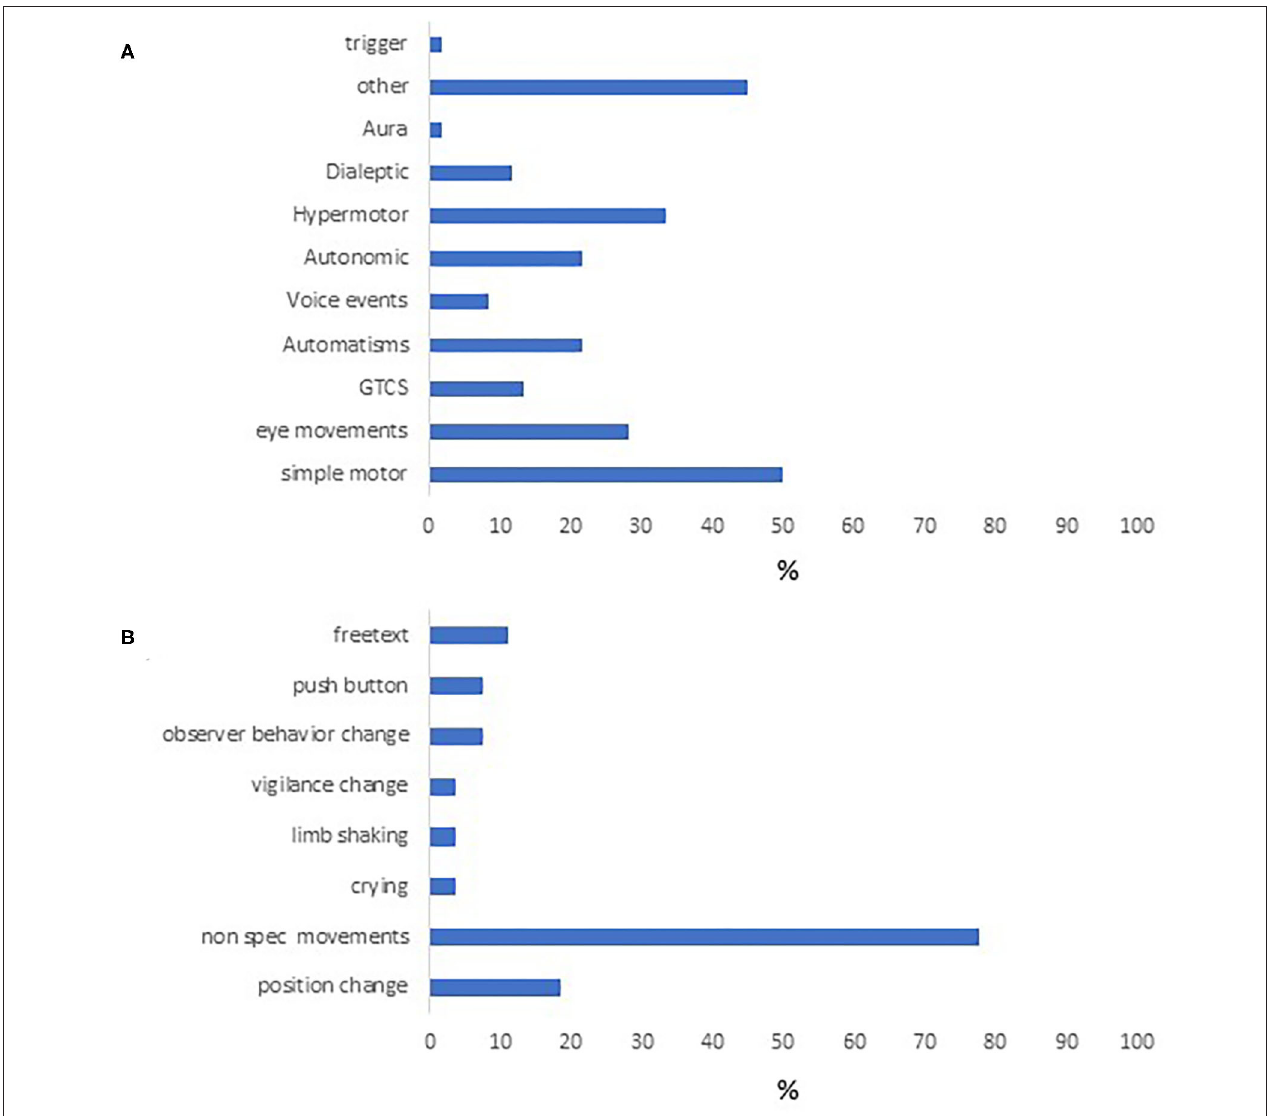
FIGURE 2 | Semiologic characteristics of the study cohort. Event types appearing in our cohort are seen in (A) . (B) contains the different behaviors under “other,” the most common of which were nonspecific limb movements, followed by position change.